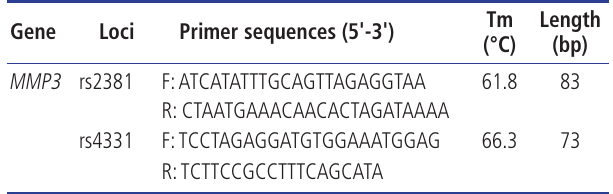
Table 1. Primes used for polymerase chain reaction amplification Primers